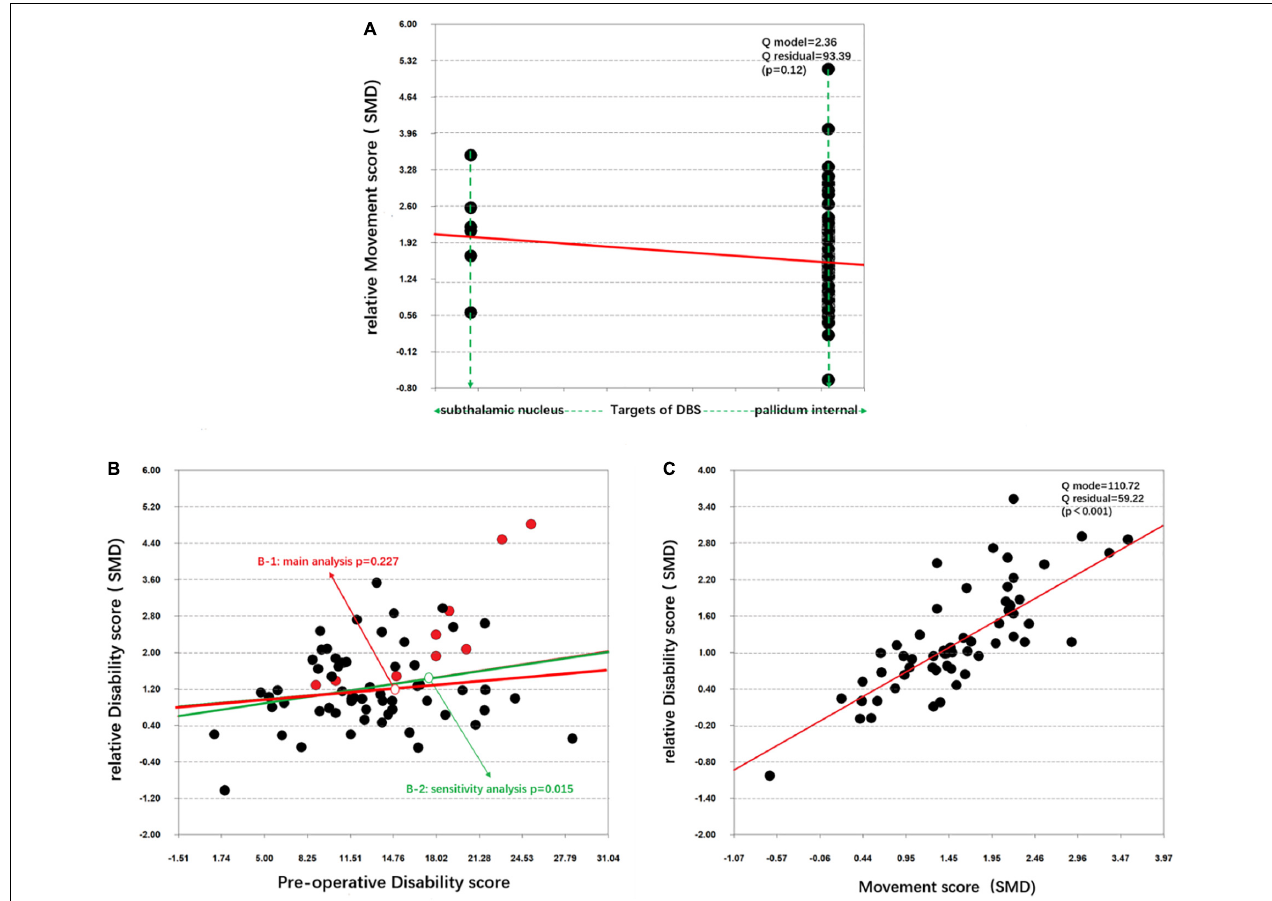
FIGURE 2 | Simple linear regression of the target differences and disability symptom improvement. (A) Correlation between the target differences and the relative movement score (SMD). (B) Correlation between the preoperative disability score and the relative disability score (SMD) in the main analysis (B-1) and the sensitivity analysis (B-2). (C) Correlation between the movement score (SMD) and relative disability score